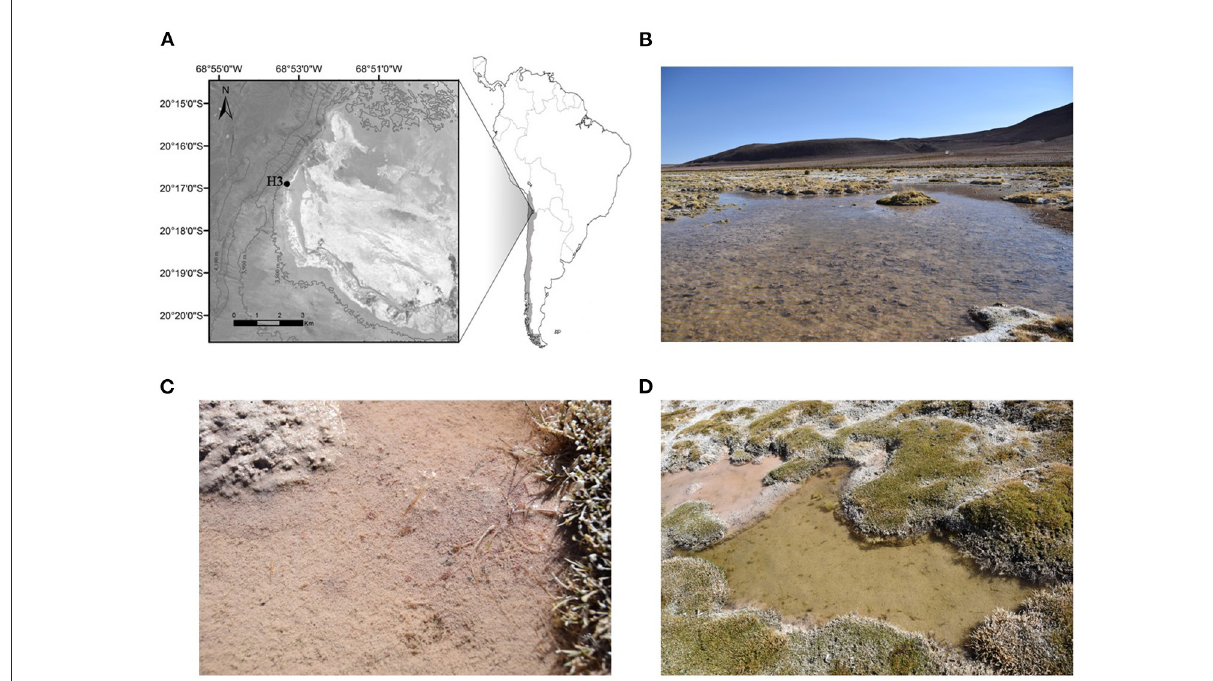
FIGURE1 (A) Map showing the location and area of the site (H3) sampled during 16-17 September 2019, (B) Shows a general imagine of “Poza Rosada” (PR), (C) Shows a close up of microbial mats that are characterized by their pink color and (D) Shows “Poza Verde” (PV) and its green color in contrast with a near pond of pink